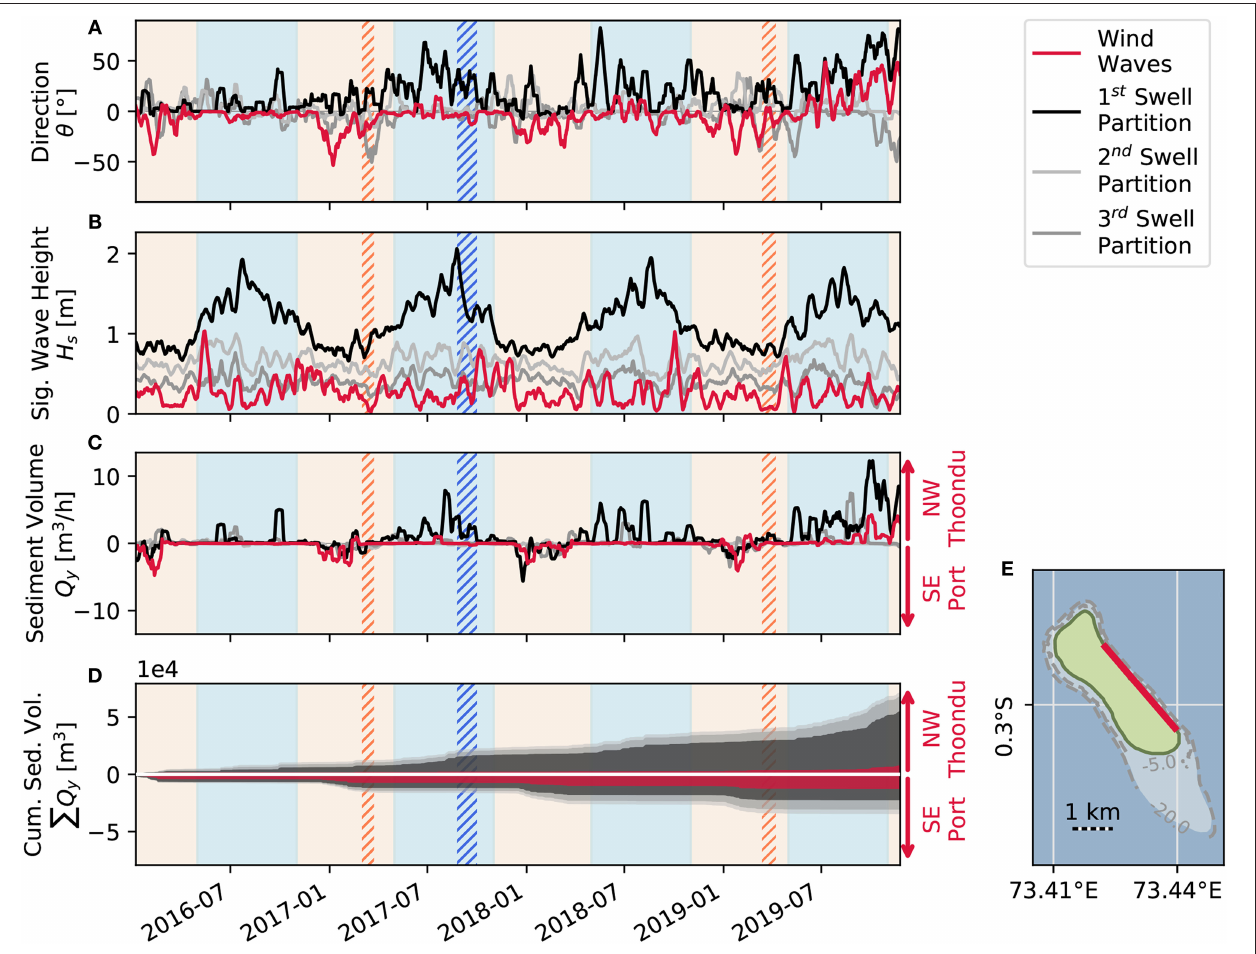
FIGURE 8 | (A) Averaged incident wave direction θ ⊥ , wp , measured as difference from the coastline normal α ⊥ and (B) wave height H s , wp of each wave partition wp used for (C) longshore sediment transport rates q y , wp and (D) cumulative sediment volume Q y , wp , transported alongshore the, marked with an crimson line on the map (E) . The crimson line is accordance with the crimson line in Figure 6 (see Table 3 for corresponding peak transport rate values q y , max and the contribution of each wave partition to Q y ). The time series shows values from January 2016 to November 2019. Negative values for q y , wp and Q y , wp indicate a transport toward the seaport in the southeast, while positive values lead to sediment transport toward Thoondu beach in the northwest. The time series shows the dry season with orange and the wet season with blue background. Field campaign 1 and 3 (orange hatched area) took place in March 2017 and 2019. Field campaign 2 (blue hatched